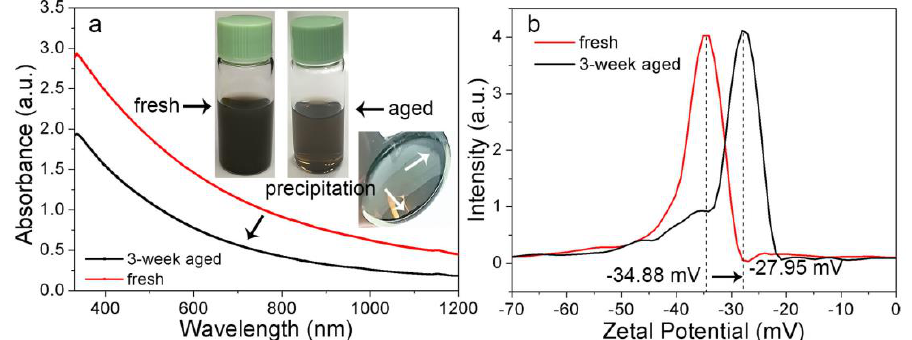
Figure 6. High resolution XPS ( a ) Fe 2p, ( b ) O 1s and ( c ) C 1s spectra from the colloids synthesized by laser ablation of Fe in